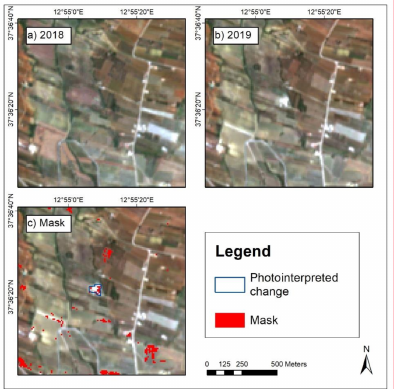
Figure 11. Example of commission errors in the masks obtained by applying the third approach. ( a ) Copernicus Sentinel-2 image (2018) before the land consumption; ( b ) Copernicus Sentinel-2 image (2019) after the land consumption. ( c ) The area inside the blue polygon represents a true change correctly detected, while the other red areas are commission errors of the